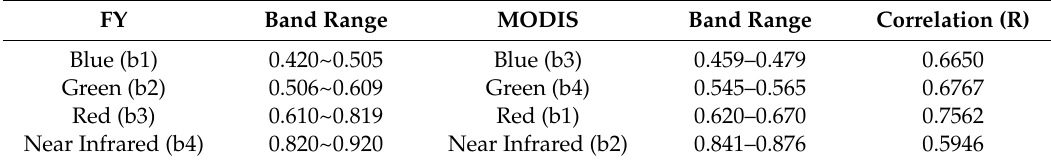
Table 4. Band range and correlation statistics of FY and MODIS surface reflectance data.